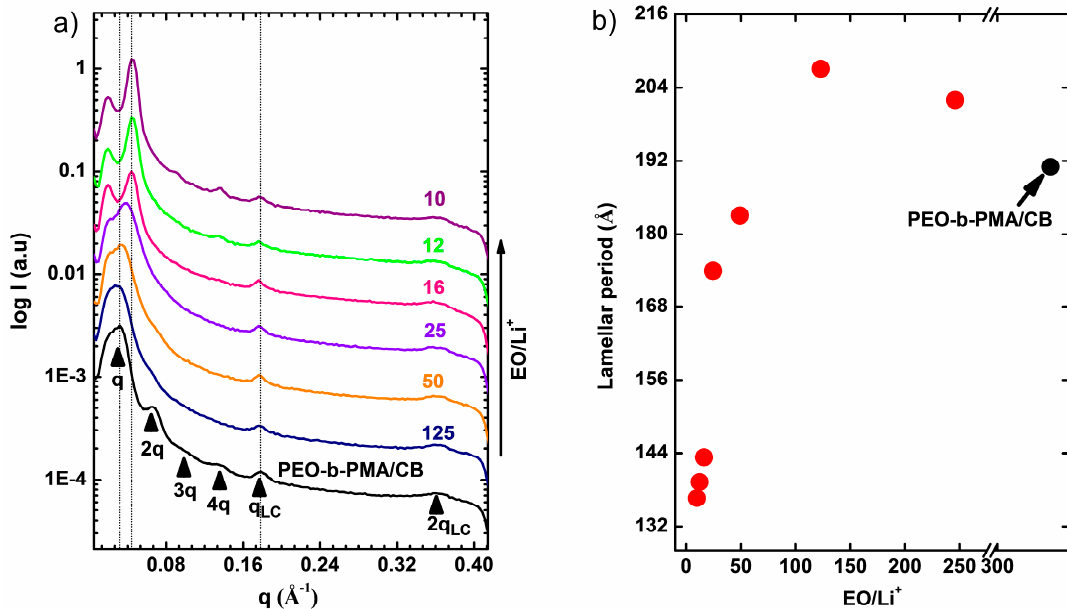
Figure 7. ( a ) Circularly integrated data of PEO-b-PMA / CB samples at di ff erent EO:Li + ratios. The samples preserve lamellar morphology at all LiClO 4 doping levels. ( b ) The lamellar period decreases with doping level above 150:1 EO:Li + ratio, while the smectic layer spacing remains